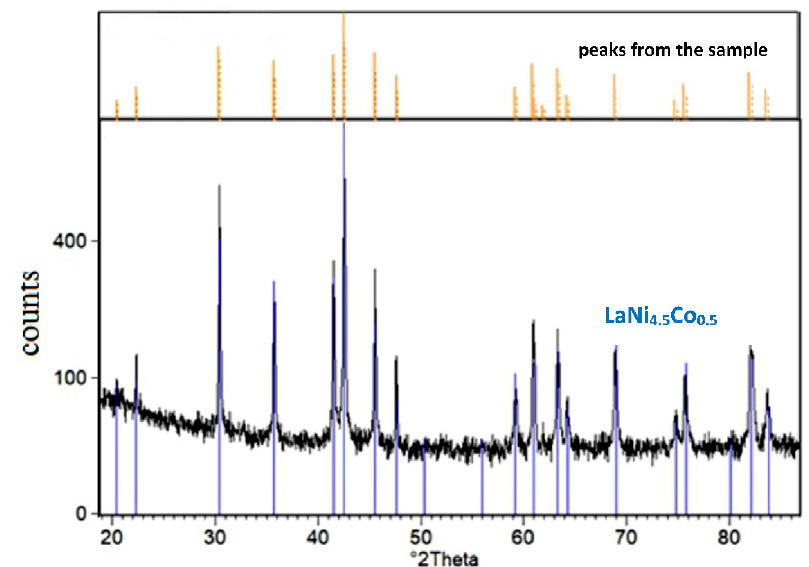
Figure 3. XRD spectrum of the tested LaNi 4.5 Co 0.5 powder sample modified by magnetron sputtering of TiCrFeCoNi HEA layer (comparison of the X-ray spectrum for the sample before and after the HEA process).